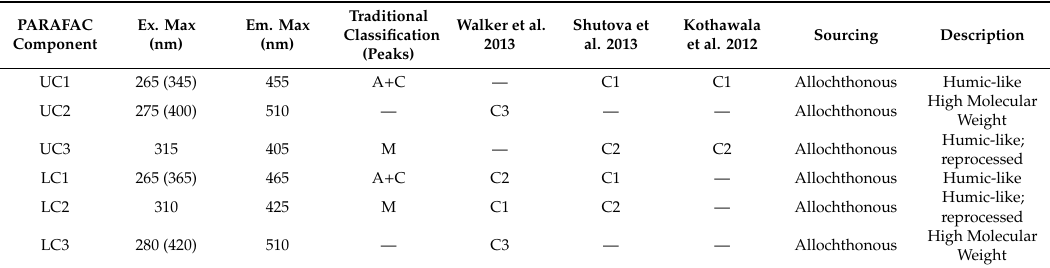
Table 2. PARAFAC modeled DOM component properties, peak classification, sourcing and references to other studies reporting comparable peaks.